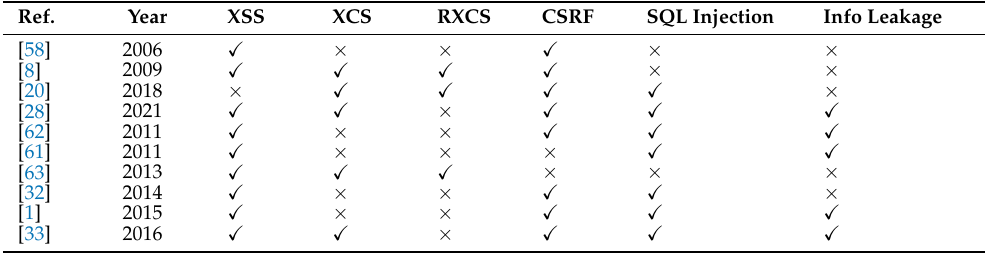
Table 5. Comparison of existing techniques to detect web application vulnerabilities.